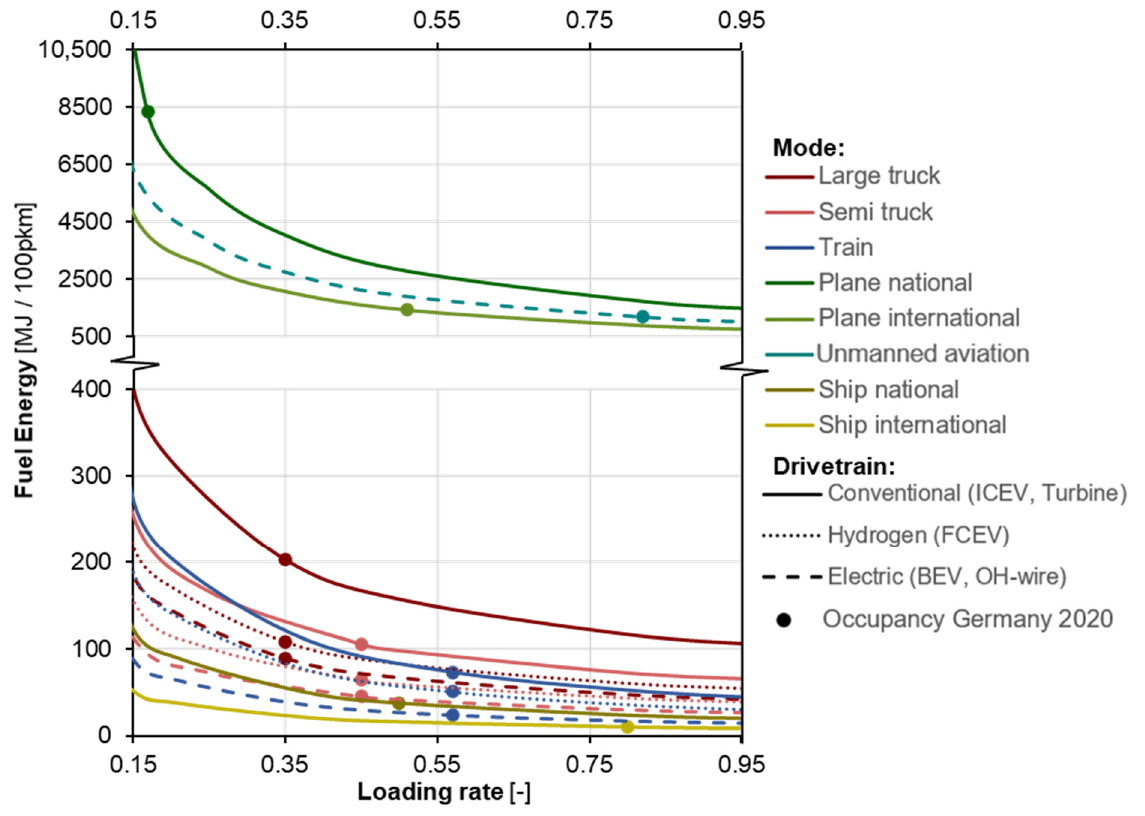
Figure 13. Fuel energy demand vs. loading rate for selected freight modes.